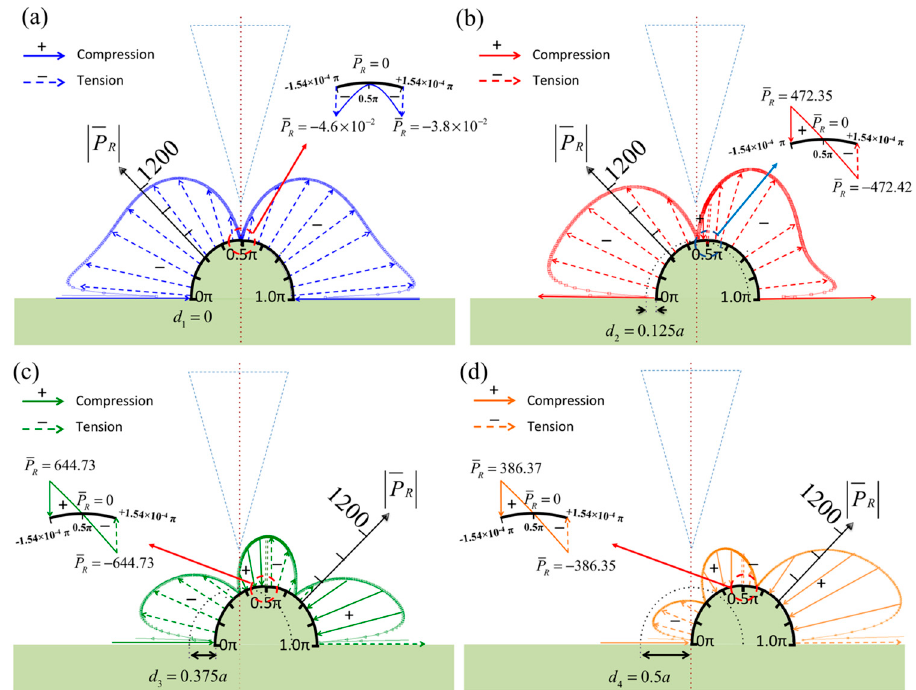
Figure 5. Normalized pressures in real part over the surface of the semicircular specimen when the diameter of the semicircle d = a , h t = 0.3 a , and the tip is shifted to the left relative to the specimen center line. The shift magnitudes are ( a ) d 1 = 0, ( b ) d 2 = 0.125 a , ( c ) d 3 = 0.375 a , and ( d ) d 4 = 0.5 a . Insets: the zero-pressure points in the apical specimen.